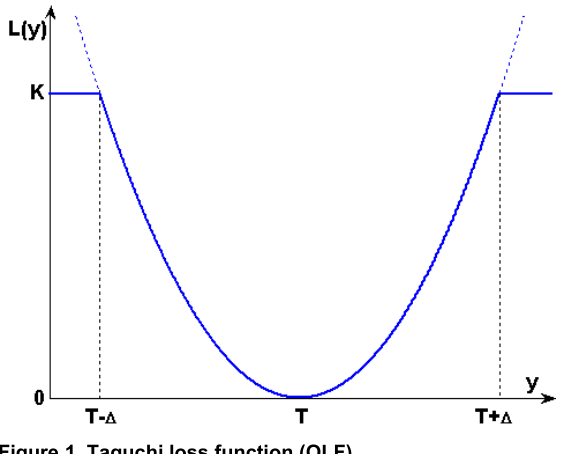
Figure 1. Taguchi loss function (QLF) The parameters K meaning as in the Taguchi LF (see Eq. (2)).